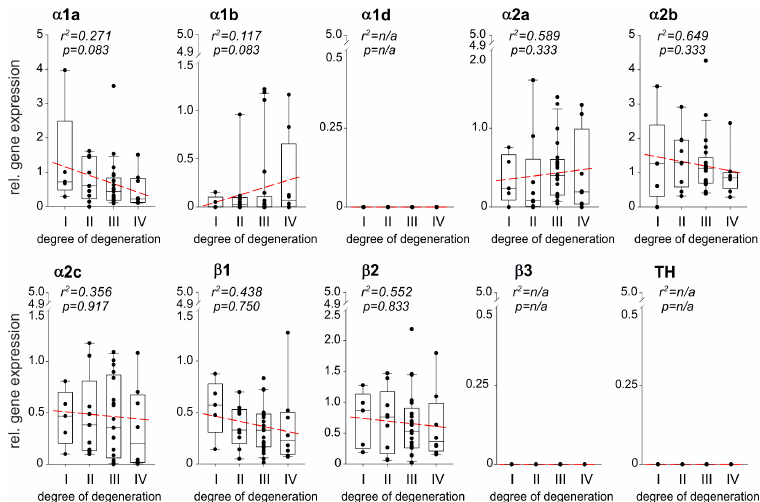
Figure 2. Correlation between AR and TH gene expression and the degree of IVD degeneration. Gene expression changes of the ARs as well as of the enzyme TH in different stages of IVD degeneration (gene expression level mean of stage I samples = 1 represented by the dashed-line). Each black circle represents an individual patient ( n = 43). Data are presented as box plots, where the boxes represent the 25th to 75th percentiles, the lines within the boxes represent the median, and the lines outside the boxes represent the 10th and 90th percentiles. The red dotted lines represent the linear regressions for each gene analyzed. Int. J. Mol. Sci. 2019 , 20 , x FOR PEER REVIEW